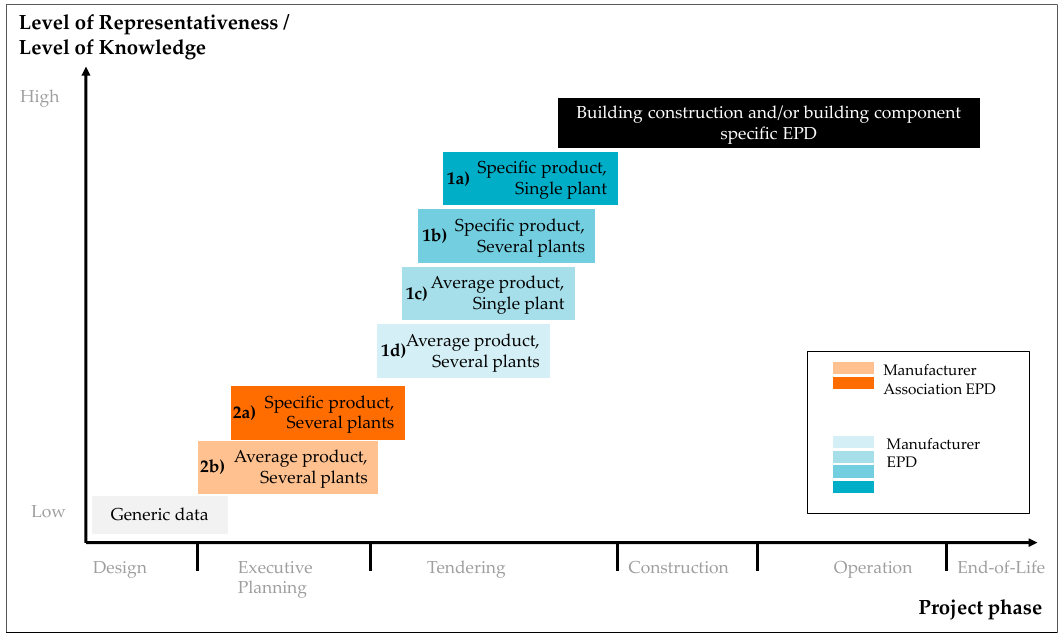
Figure 2. Overview on possible environmental product declaration (EPD) data types and their application for LCA purpose in different project phases.